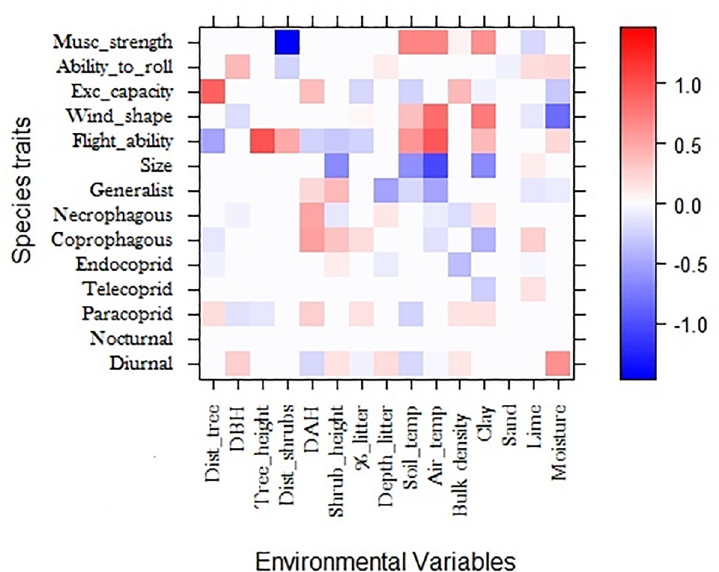
Fig 3. Results of the fourth-corner model in relation to traits-variable. Traits are colored according to their fourth- corner coefficients: red indicates a significant positive trait-variable association, and blue indicates a significant negative trait-variable association. Color depth indicates the strength of the trait-variable